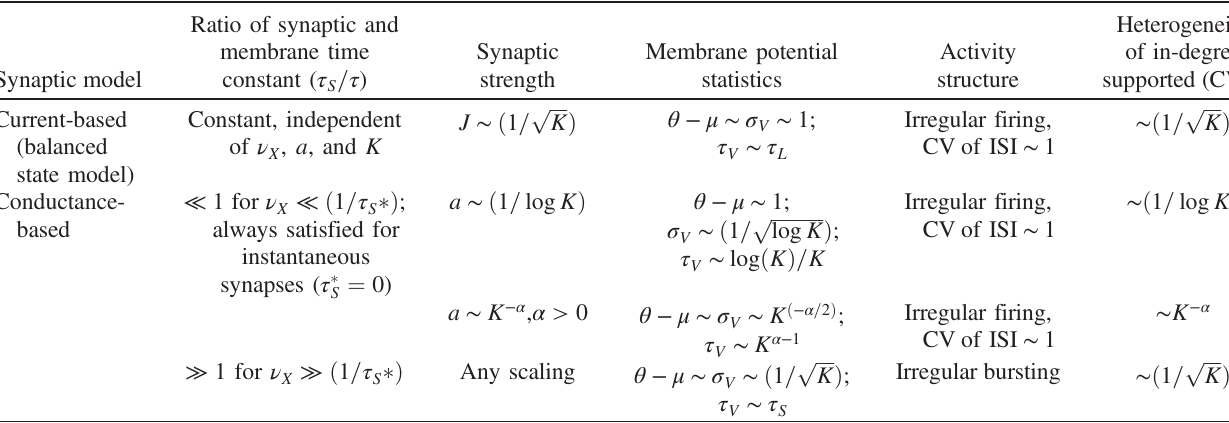
TABLE I. Overview of networks of current-based and conductance-based neurons. The synaptic time constant strongly affects response properties in networks of conductance-based neurons. Properties similar to what is observed in the cortex emerge in these networks if a ∼ 1 = log K and input rates are lower than or comparable to 1 = τ (cid:3) [defined in Eq. (26)]. The model predicts that response S properties should gradually mutate as the input to the network increases and, for large inputs, should coincide with those indicated in the last line of the table. In the table, the different quantities related to the membrane potential represent the mean distance from threshold ( θ − μ ), the size of temporal fluctuations ( σ ), and the membrane potential correlation time constant ( τ V V